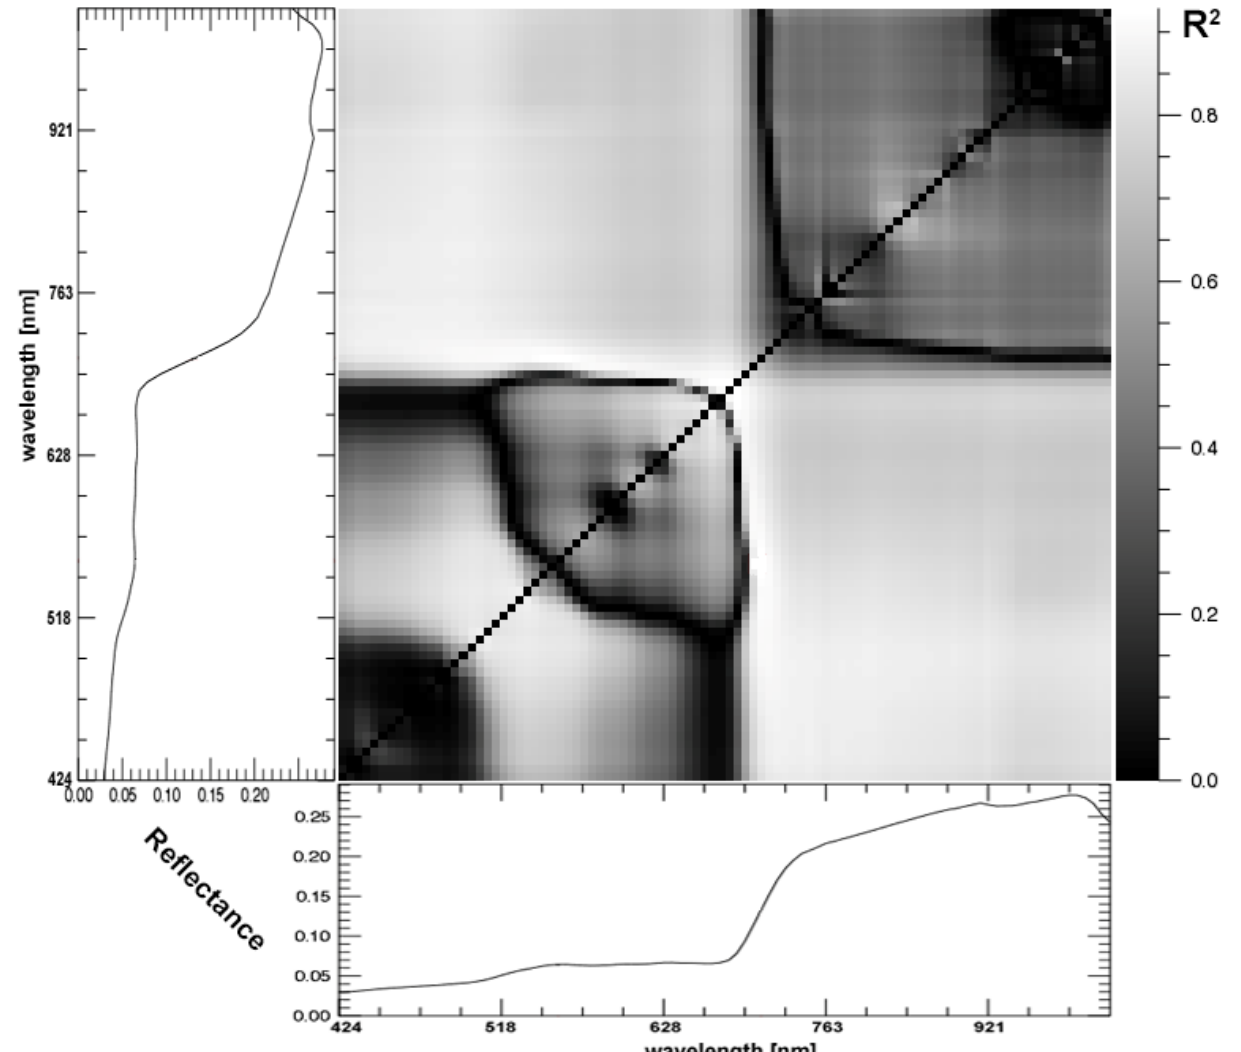
Figure 4. Map of R 2 values of hyperspectral two-band vegetation indices (HTBVI) of all possible simulated EnMAP band combinations correlated with